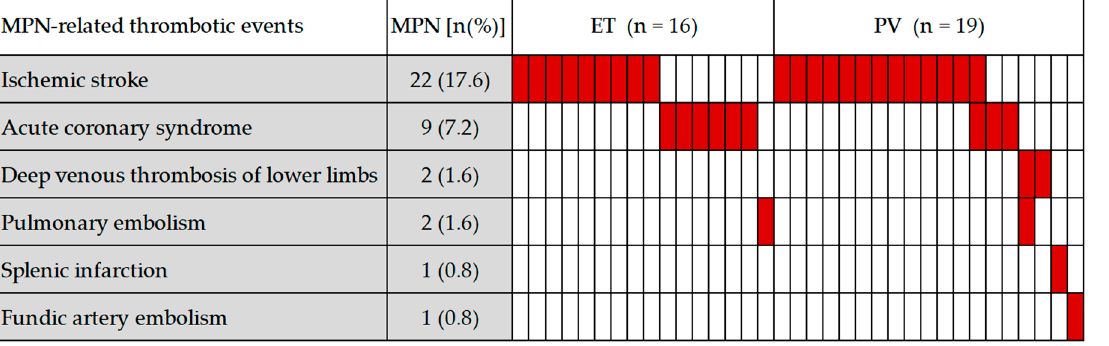
Figure 3. Distribution and frequency of MPN-related thrombotic events. Each column represents one patient.